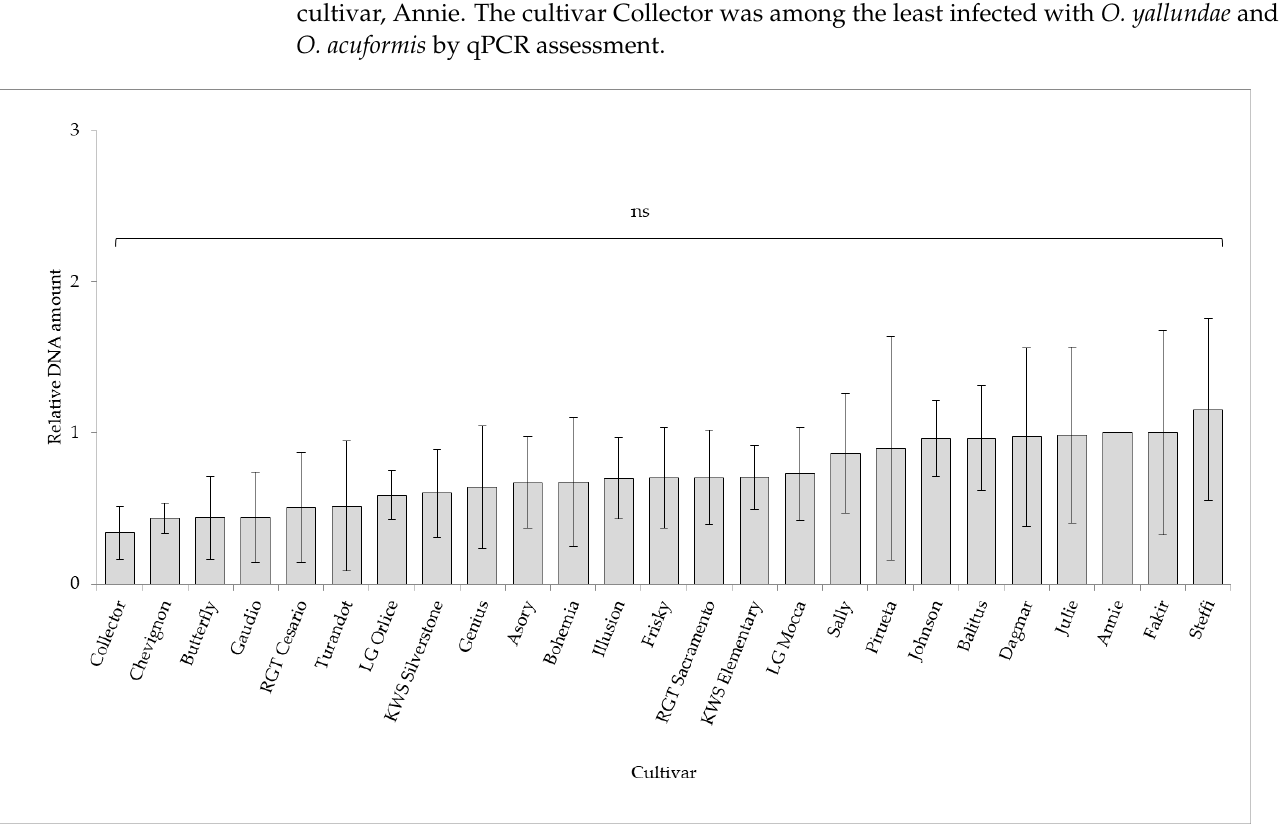
Figure 2. The qPCR assessment of Oculimacula acuformis in the winter wheat cultivars (2019–2021). The ANOVA was not statistically significant (ns).